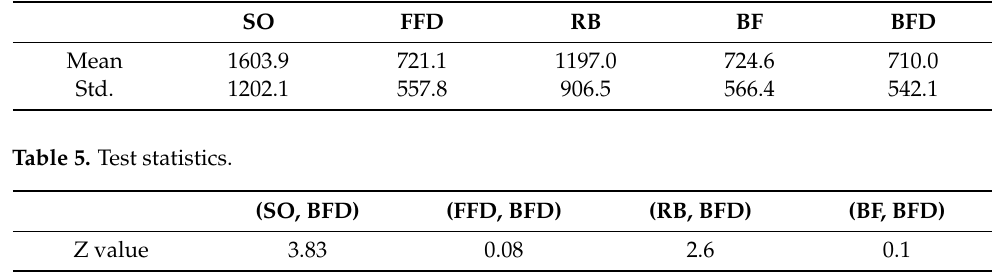
Table 4. Mean value and standard deviation of initial solutions (unit: m).